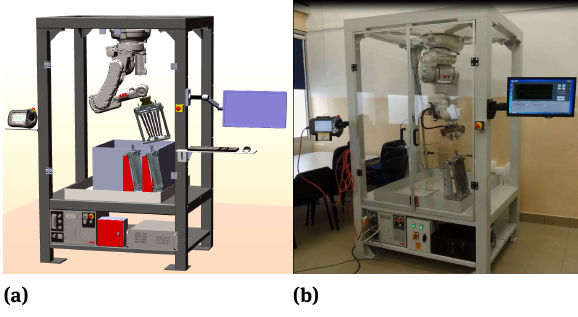
Figure 1: Test stand (a) RobotStudio software (b) Actual test